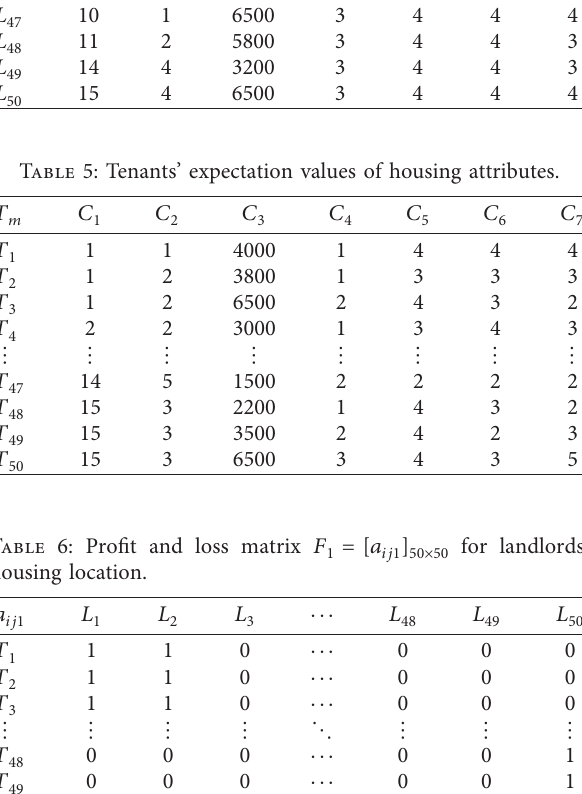
Table 5: Tenants’ expectation values of housing attributes.